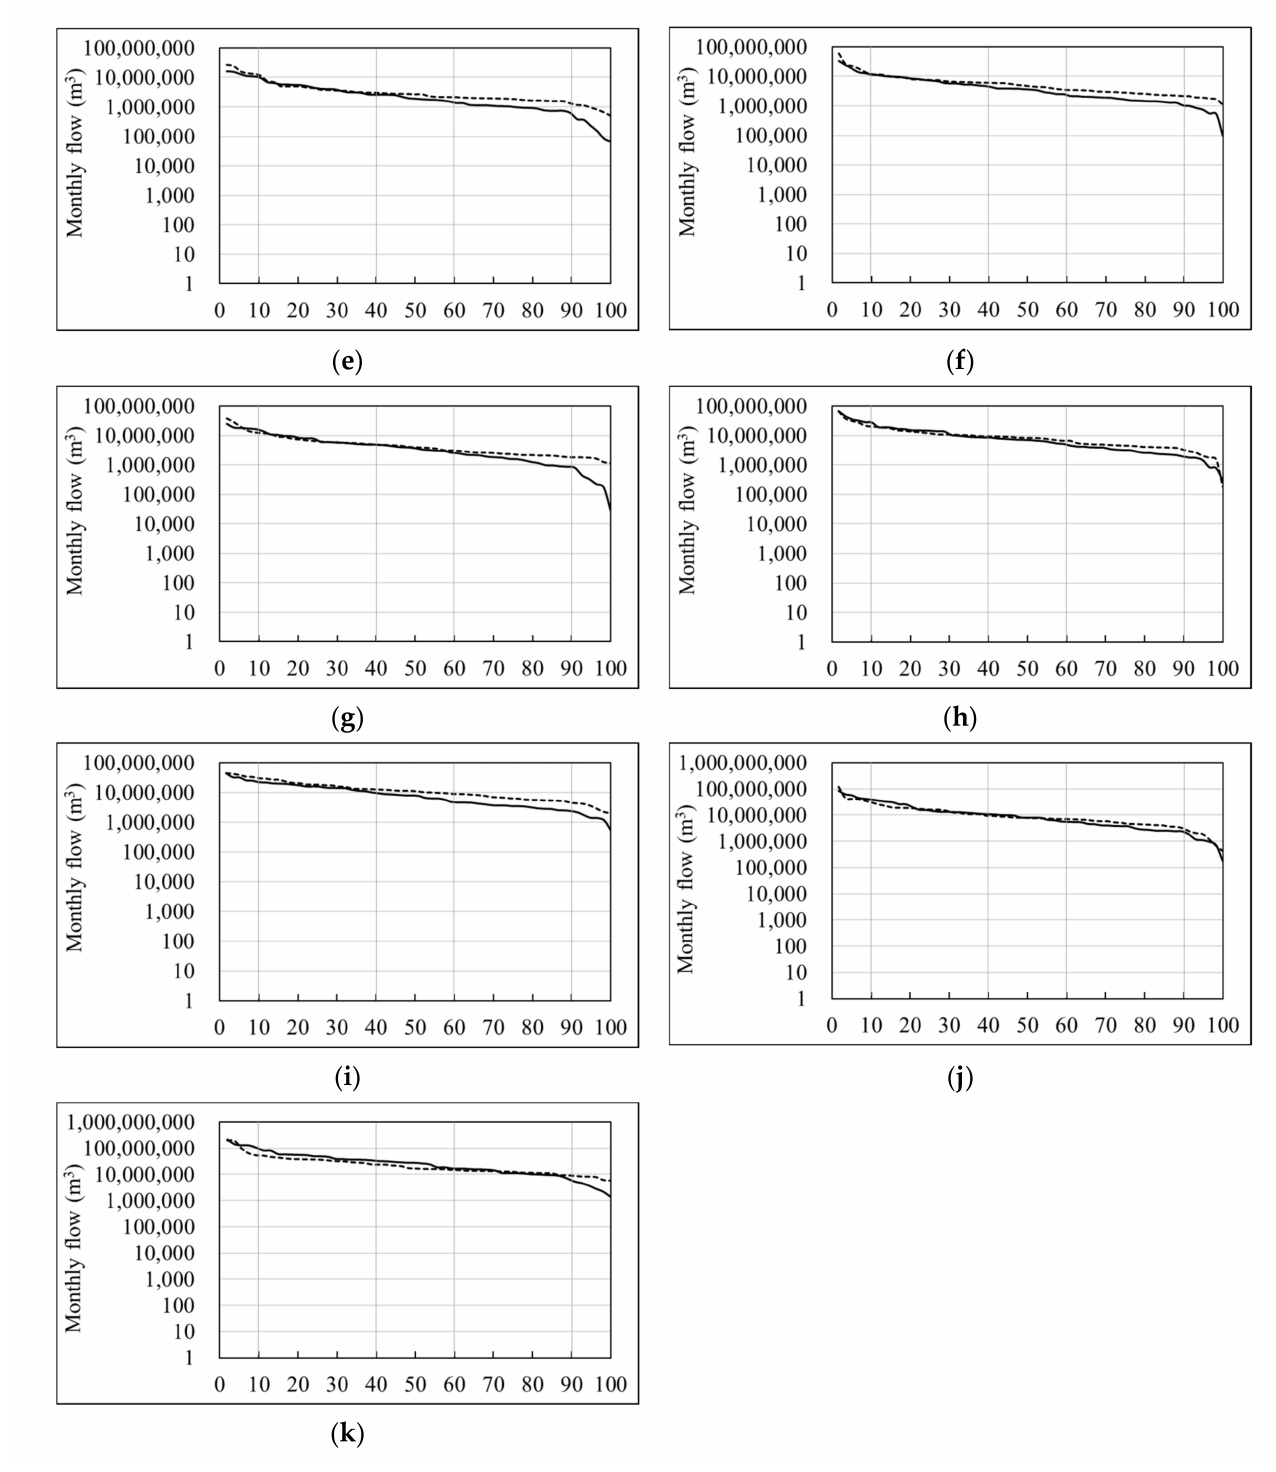
Figure 4. Flow duration curves of separated monthly baseflow and estimated monthly baseflow in calibration: ( a ) Wsd-01; ( b ) Wsd-02; ( c ) Wsd-04; ( d ) Wsd-06; ( e ) Wsd-08; ( f ) Wsd-10; ( g ) Wsd-12; ( h ) Wsd-14; ( i ) Wsd-16; ( j ) Wsd-18; ( k )